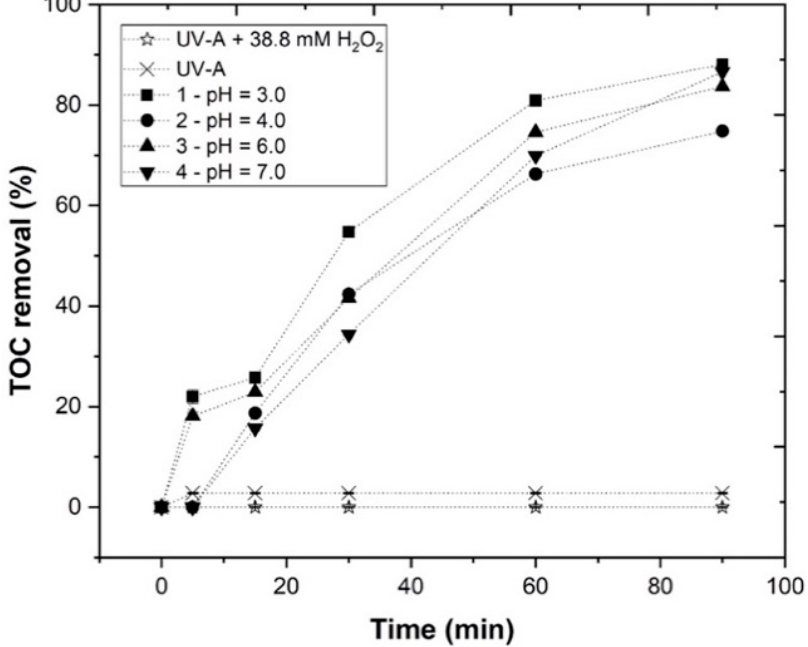
Figure 8. Progress of TOC percentage removal at different pH (3–7) in the UV-A-Fenton process. Experimental conditions: [H 2 O 2 ] = 38.8 mM, [Fe 2+ ] = 1.0 mM, agitation = 350 rpm, T = 25 °C, radiation = UV-A, I UV = 32.7 Wm − 2 , t = 90 min. Blank non-catalytic experiments (UV-A/H 2 O 2 and UV-A without H 2 O 2 ) are also represented as a reference.